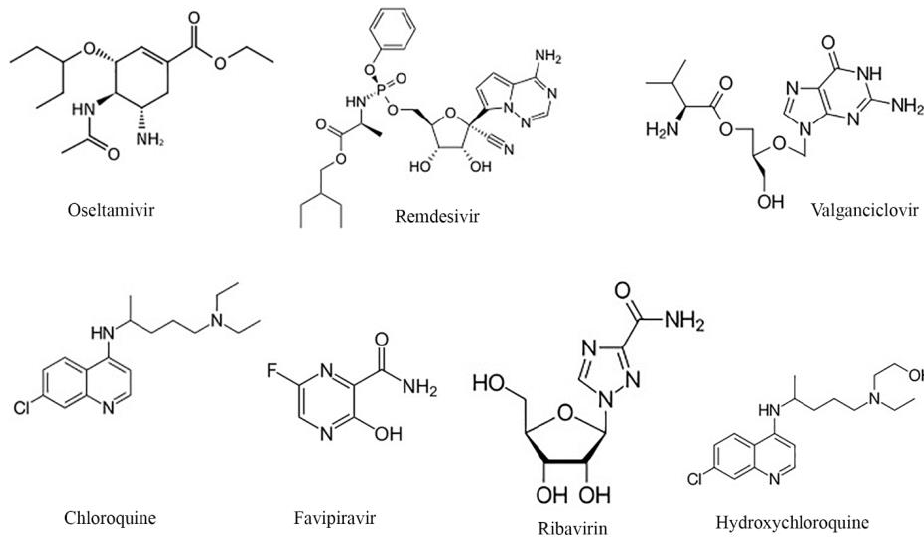
Figure 2. The phytochemical structures of antiviral drugs studied.